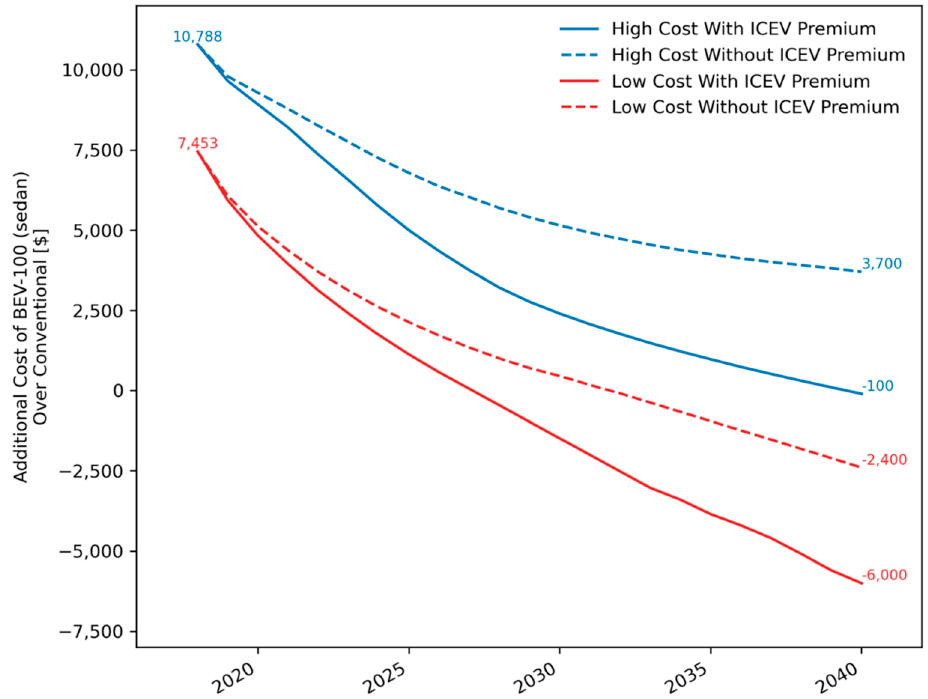
Figure 4. The additional capital cost, over time, of a BEV 100-mile (160 km) range sedan versus “equivalent” ICEV, in four cost scenarios (combinations of Low and High Non-Battery Cost and with and without ICEV Cost Premium, gasoline price = USD 2.60 per gallon = EUR 0.65 per liter), with heterogeneous consumers. A value of zero indicates upfront cost parity for BEVs. Results show that uncertainty in current BEV cost and future ICEV cost lead to very different trajectories for cost parity. (BEV = Battery Electric Vehicle; ICEV = Internal Combustion Engine Vehicle).